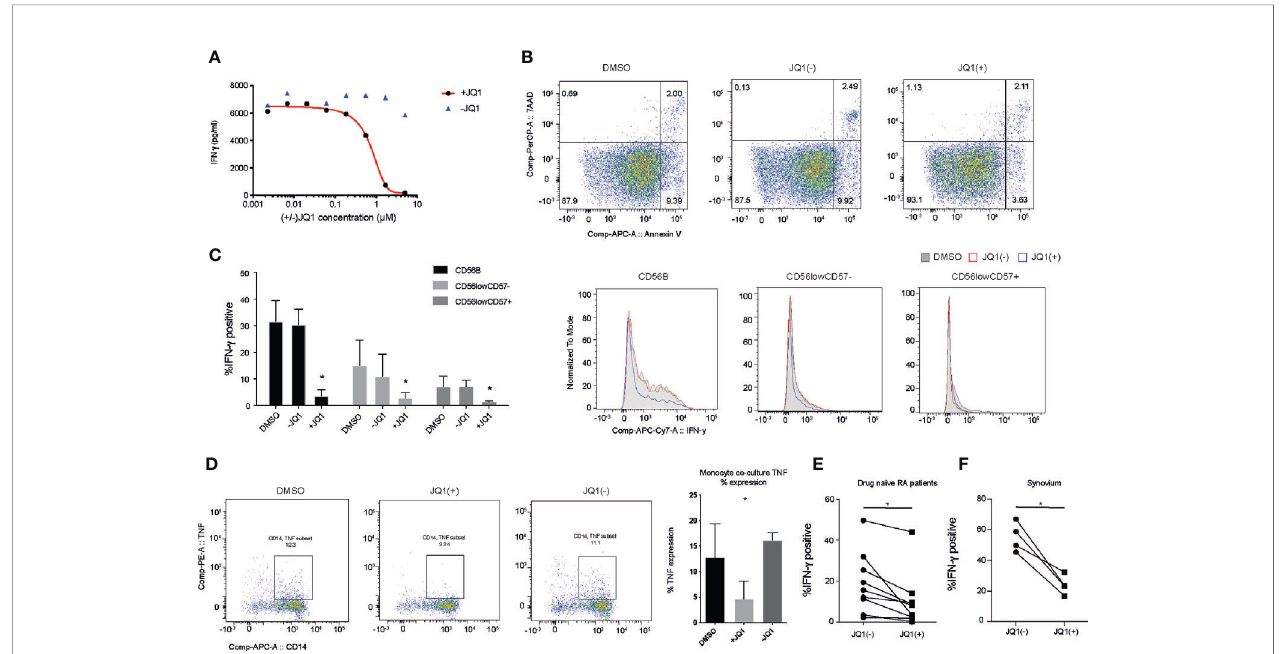
FIGURE 2 | JQ1(+) bromodomain inhibitor inhibits NK cell mediated in fl ammatory function. (A) The measurement of IFN- g in the culture supernatant following stimulation of NK cells with IL-15 (10 ng/ml) and 24 h of treatment with JQ1(+) and the negative control JQ1( − ). (B) Flow cytometry analysis of 7-AAD and Annexin-V expression as markers for cell death in NK cells, following 48 h of treatment with DMSO, JQ1(+) or JQ1( − ). (C) Flow cytometry analysis of IFN- g staining for NK cells stimulated with IL-15 (10 ng/ml) and treated for 24 h with DMSO, JQ1(+) or JQ1( − ). The frequency of IFN- g positive cells is shown for CD56 bright CD57 − , CD56 dim CD57 − and CD56 dim CD57 + NK cell populations. (D) Flow cytometry analysis of CD14 + monocytes following co-culture with NK cells stimulated with IL-15 (10 ng/mL) and pre-treated with DMSO, JQ1(+) or JQ1( − ) for 24 h. Cells were stained with CD14 and TNF- a and then analyzed by fl ow cytometry. (E) The frequency of IFN- g positive cells in NK cells isolated from the peripheral blood of drug-naïve RA patients. (F) The frequency of IFN- g positive cells in total NK cell populations isolated from RA synovial tissue. For (E, F) , P values were calculated using a Wilcoxon matched-pairs test. For (C, D) , P values were calculated using a Mann – Whitney U test. *P < 0.05. Error bars show mean ± SD (n =